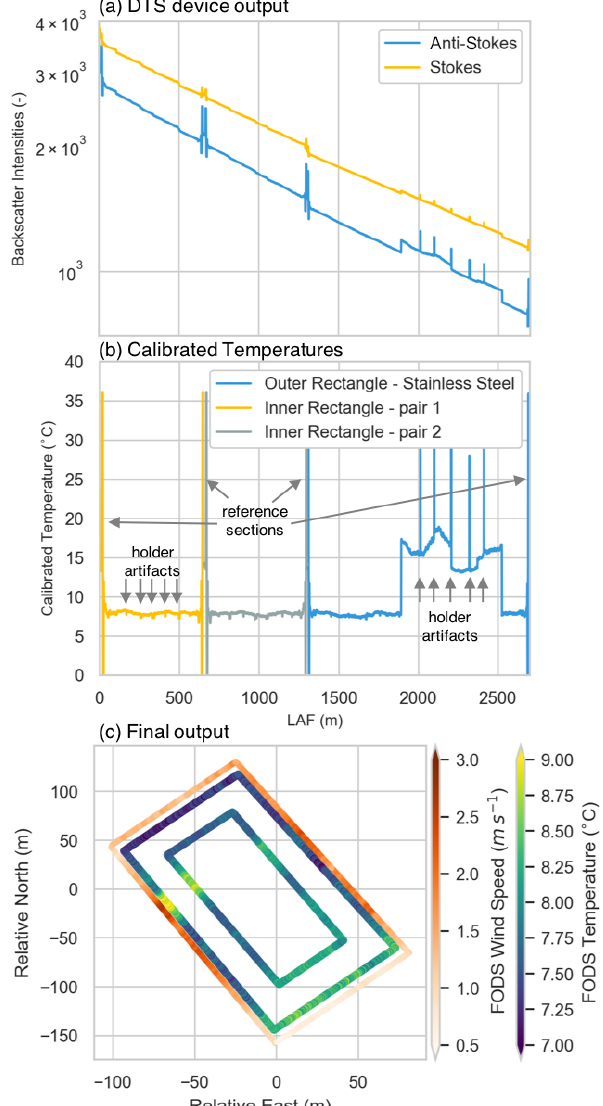
Figure 4. An example of the conversion of the DTS data from the (a) instrument-reported Stokes and anti-Stokes backscatter intensi- ties. (b) These intensities are calibrated following Hausner et al. (2011) using the reference sections. Panels (a) and (b) share the x coordinate, which is the instrument-reported length along fiber (LAF). The heated sections of the stainless steel fiber can be seen between the 1900–2500m LAF. (c) The calibrated temperatures are mapped from the LAF to physically labeled locations with artifacts from the fiber holders removed and the wind speed perpendicular to the fiber derived from the temperature difference between the heated and unheated sections of fiber (Sect. 5.1). The sub-mesoscale fea- ture seen in (c) is analyzed in more detail in Sect. 6.2 and Fig. 11 in order to highlight the utility and novelty of